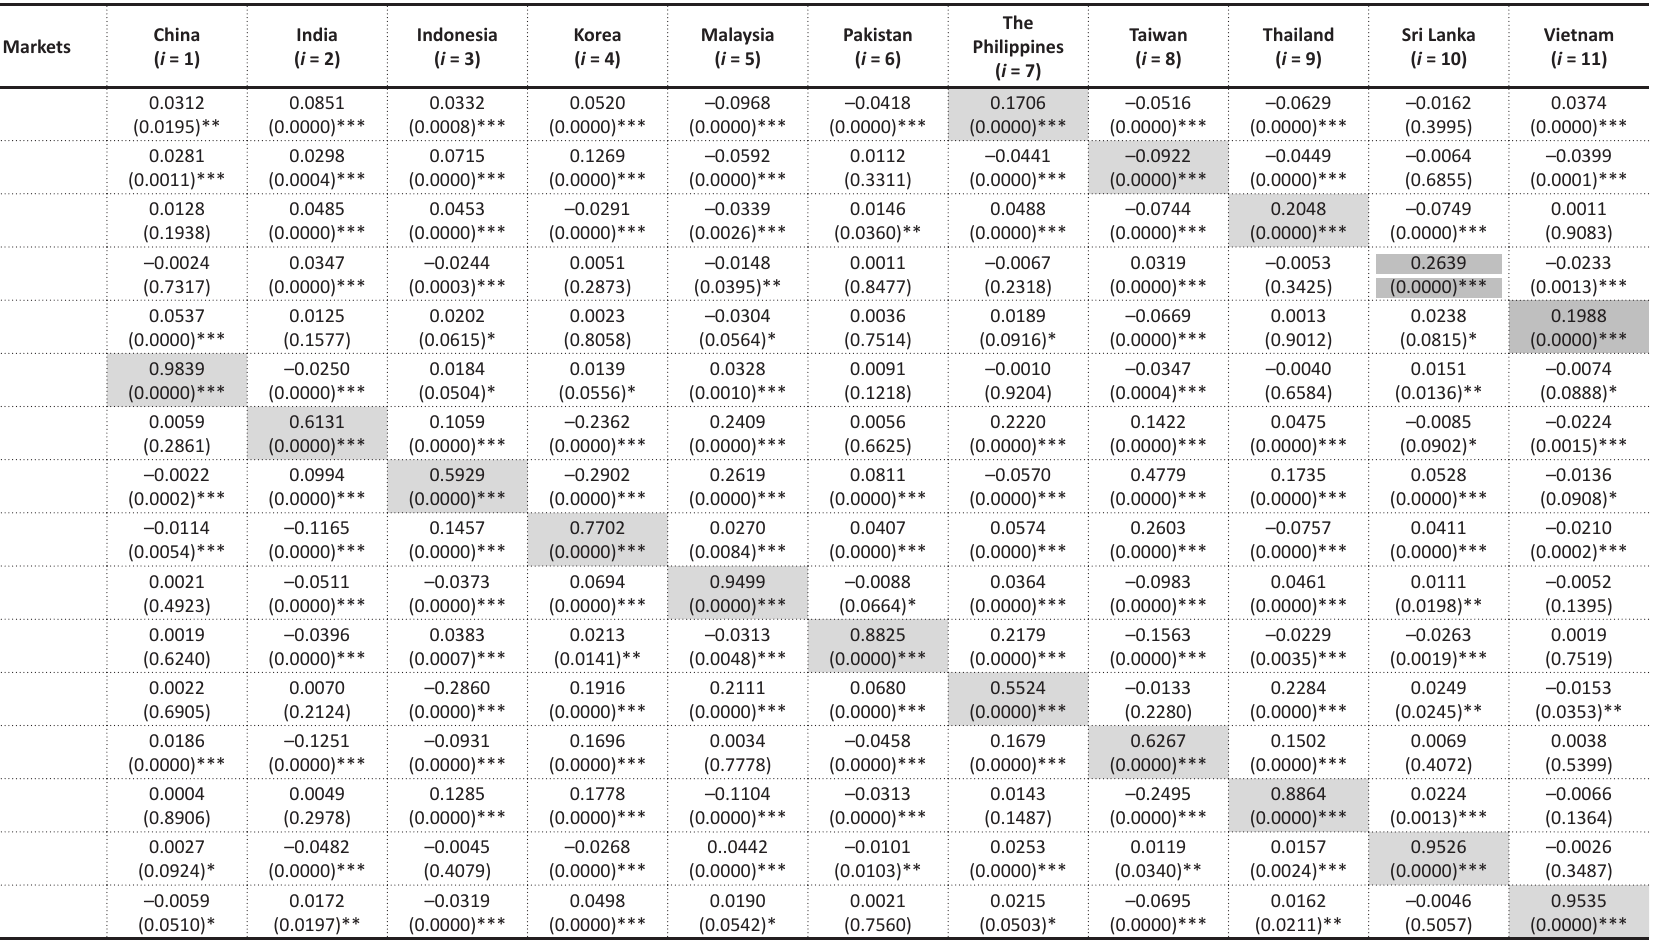
Table 6 (cont.). Shocks and volatility spillover between stock markets during post-global financial